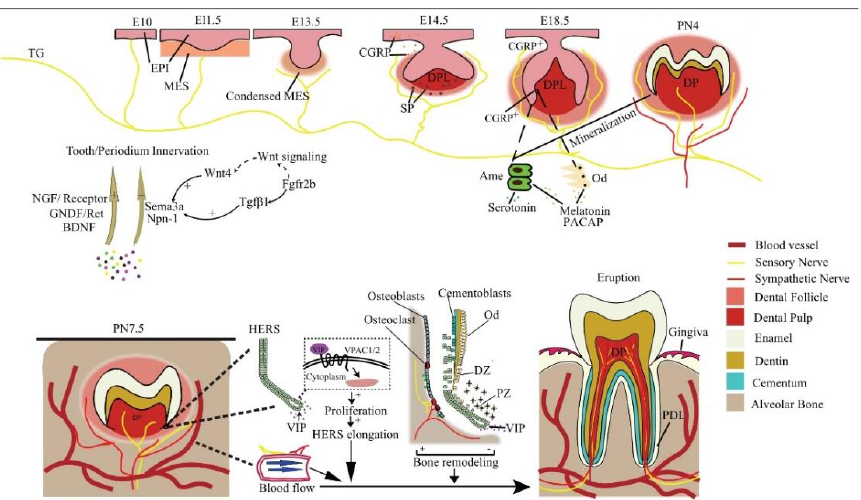
Figure 1. Reciprocal regulation between developing tooth and its innervation. NGF, GNDF, and BDNF promote nerve growth, while Sema3a and Npn-1 suppress it and ensure normal patterning. In a mouse embryo, the pioneering trigeminal ganglion (TG) fibers first arrive at the maxillary oral epithelium on E10. On E14.5, SP is detected and is essential for tooth development to continue. The sensory fibers grow into the dental follicle on E18.5. CGRP, PACAP, melatonin, and serotonin regulate tooth mineralization. Sensory fibers enter the dental pulp on PN4, while the sympathetic fibers enter it on PN 9, after root formation has begun. Neural VIP promotes the elongation of HERS to stimulate the differentiation of DF cells, resulting in root growth. Periodontal nerves regulate bone remodeling as well as the local blood flow in alveolar sockets to affect tooth eruption. EPI = epithelium; MES = mesenchyme; Ame = ameloblast; Od = odontoblast; NGF = nerve growth factor; DPL = dental papilla; DP = dental pulp; PDL = periodontal ligament; CGRP+ = CGRP positive cells; DZ = differentiation zone; PZ = proliferation